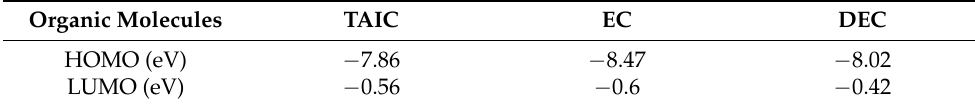
Table 2. HOMO and LUMO levels of TAIC, EC and